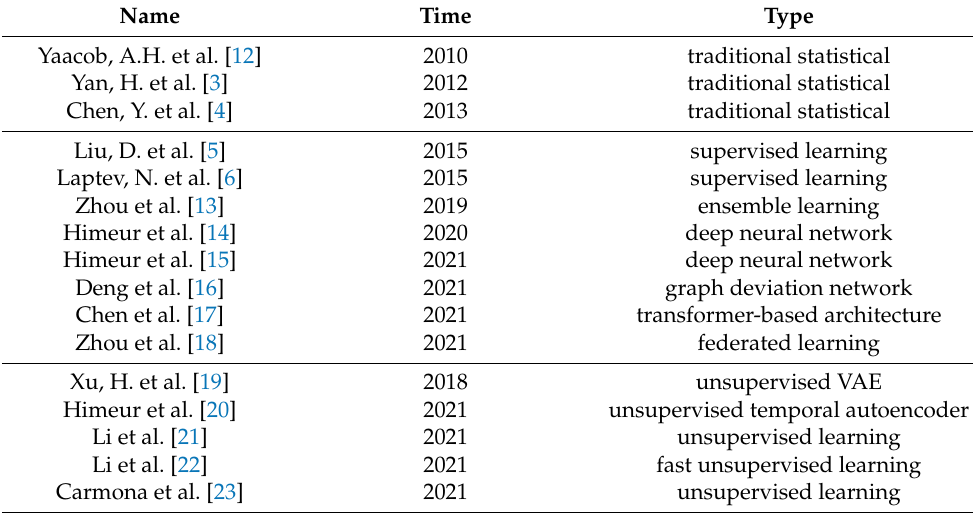
Table 1. KPI Anomaly Detection